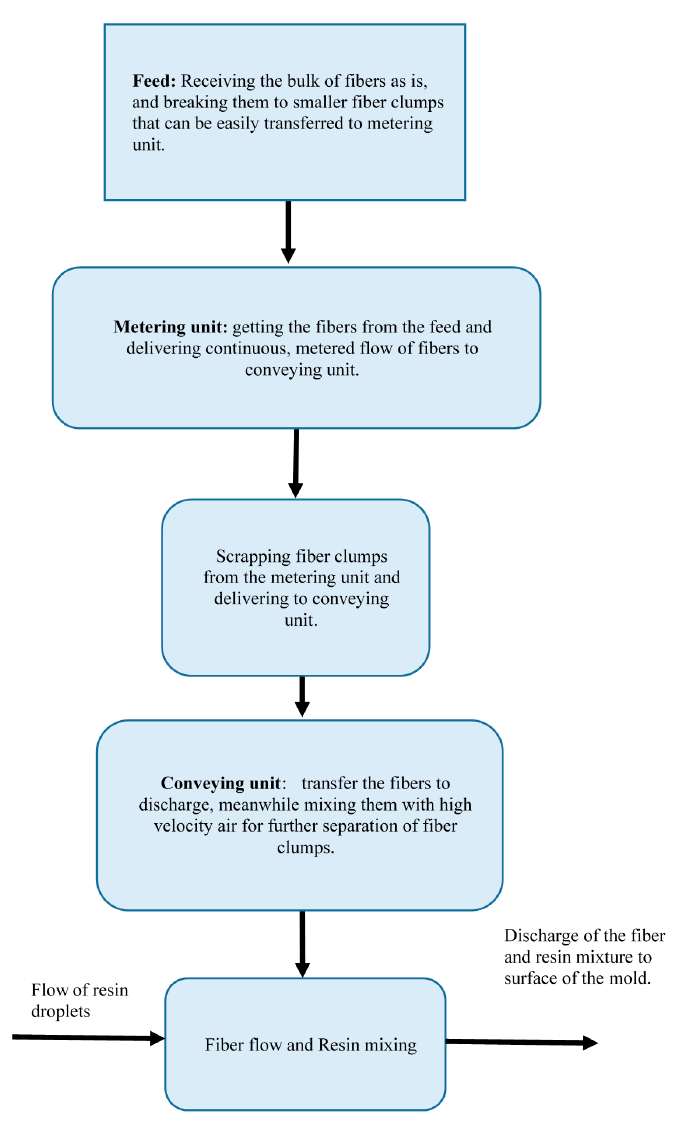
Figure 3. Flow chart of integrated unit design.